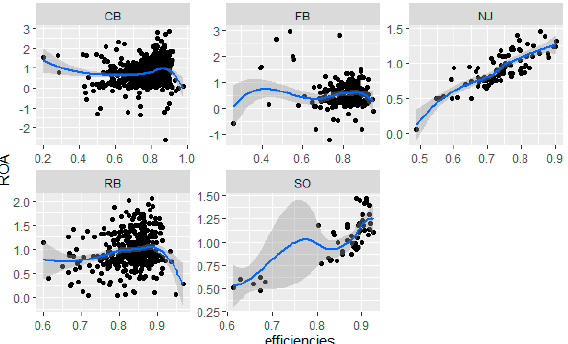
Figure 6. The relationship between pro fi t e ffi ciency and return on assets (ROA) for di ff erent types of banks. Source: author’s preparation. Notes: ordinate axis − average value of return on assets for the group of banks; abscissa axis − value of e ffi ciency; categories − groups of banks according to Table 4; each point characterizes the position of a particular bank in the coordinate system used, while the blue line determines the statistical relationship of data.